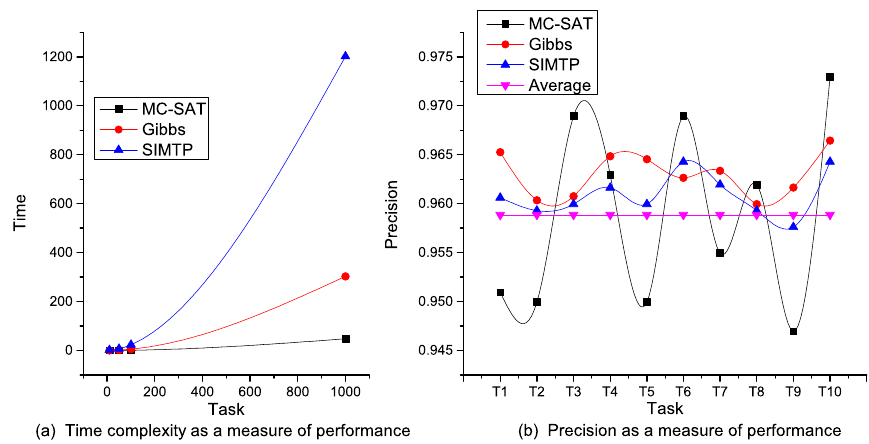
Figure 10. Performance of propositional and lazy probabilistic inference algorithms. ( a ) Time complexity as a measure of performance; ( b ) Precision as a measure of